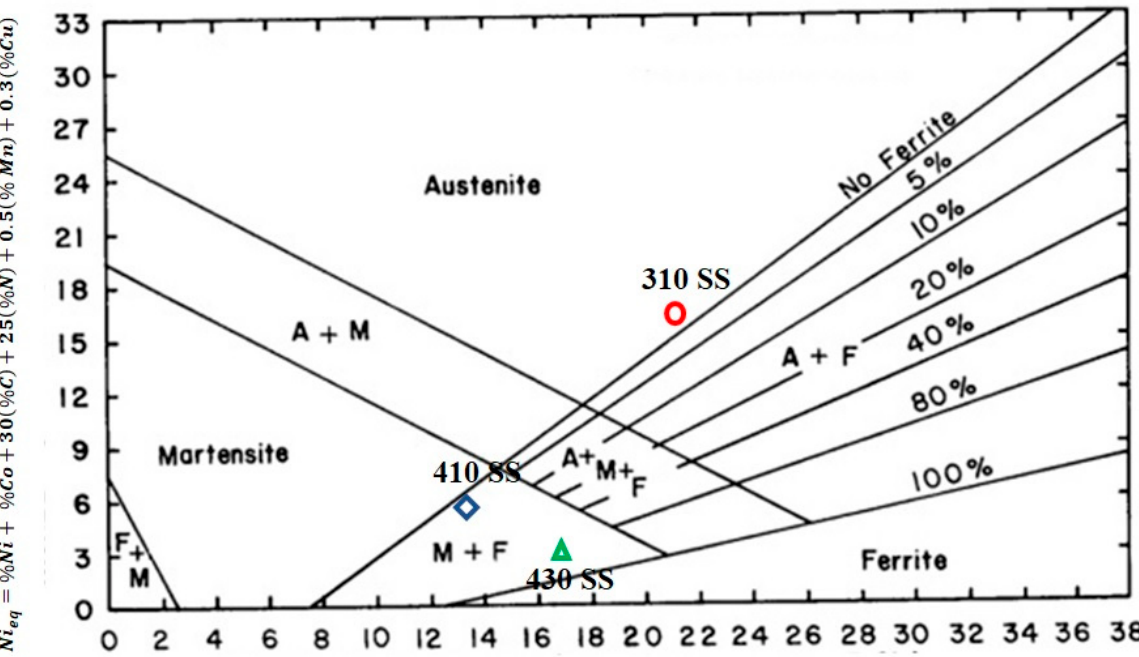
Figure 3. Schaeffler diagram.